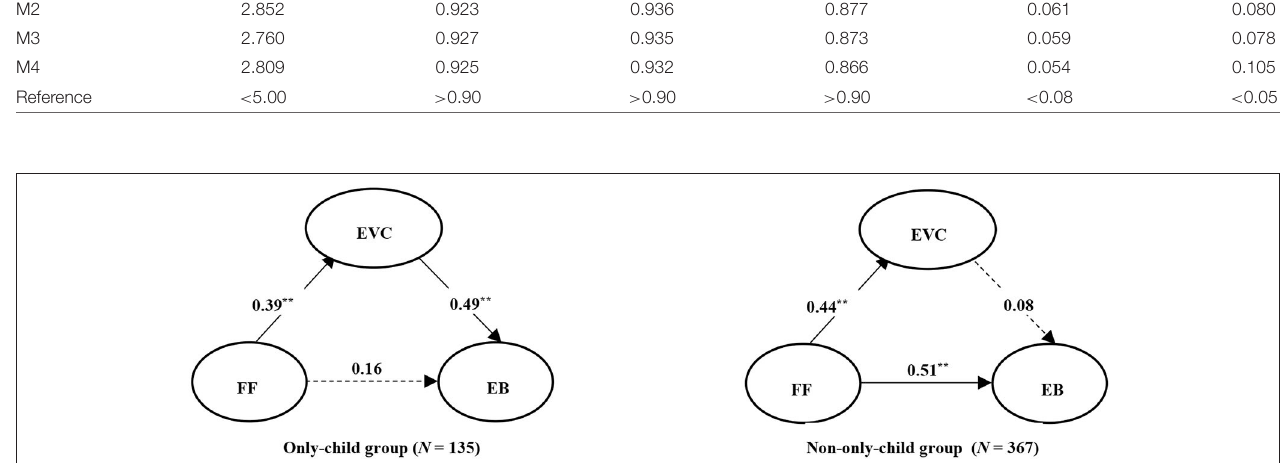
FIGURE 2 | Path relationship diagram of Mediation model in two groups. ** p < 0.001. FF, family function; EVC, exercise value cognition; EB, exercise behavior. The values in the figure are standardized path